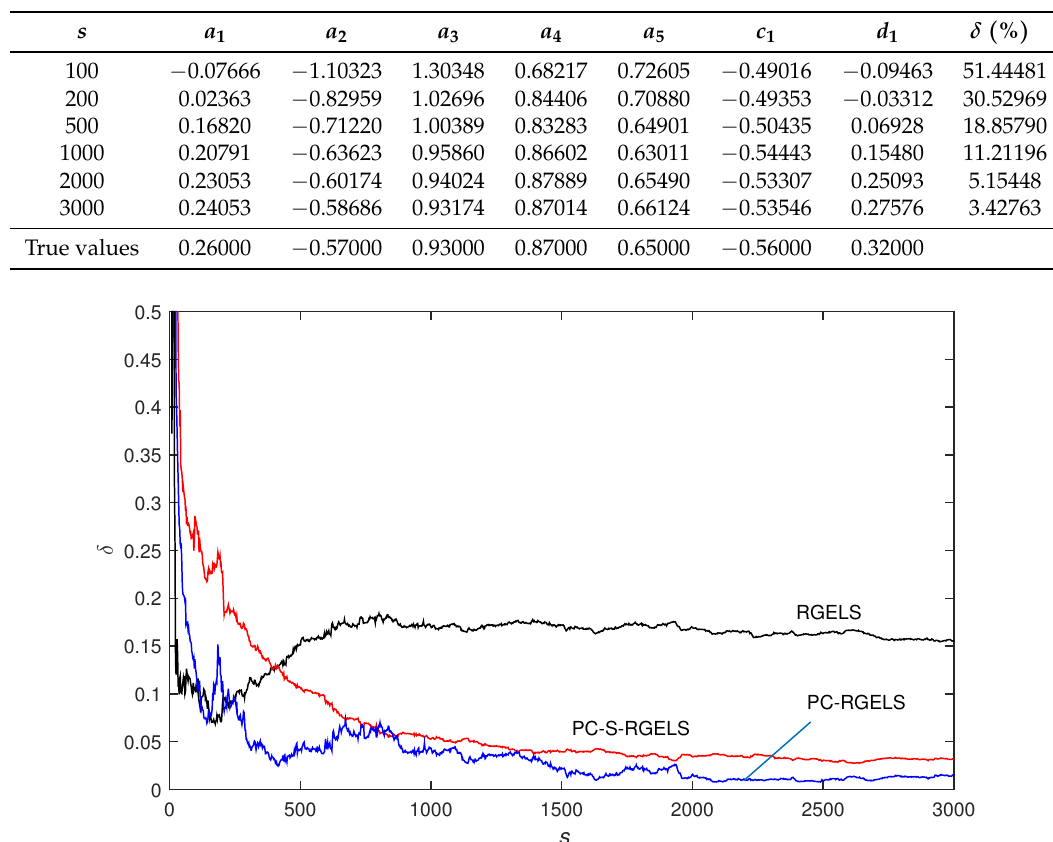
Table 5. The PC-RGELS estimates and their errors with σ 2 = 0.60 2 .